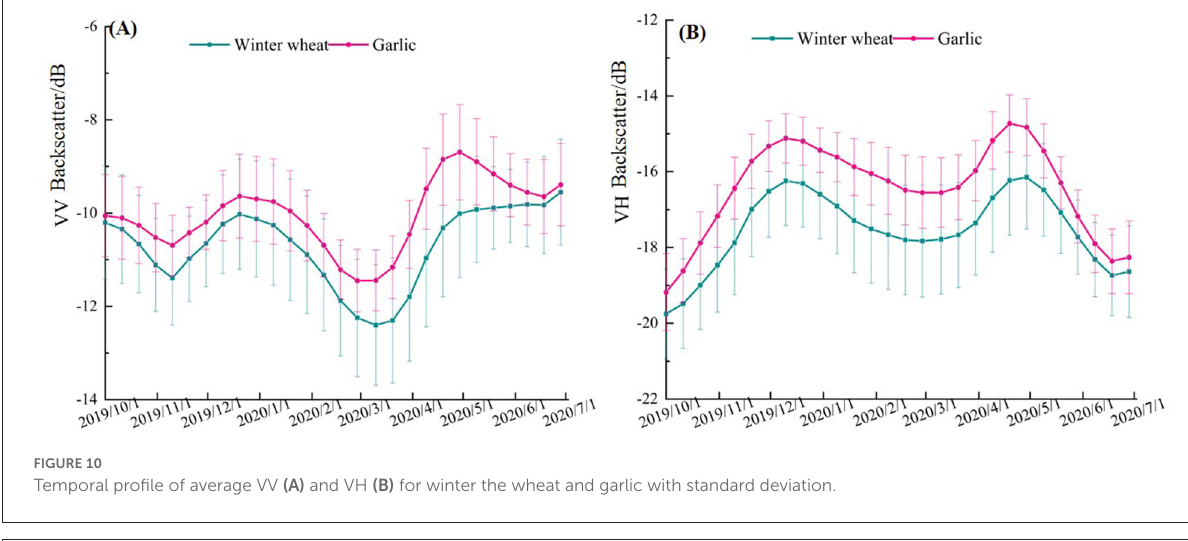
FIGURE10 Temporal profile of average VV (A) and VH (B) for winter the wheat and garlic with standard deviation.